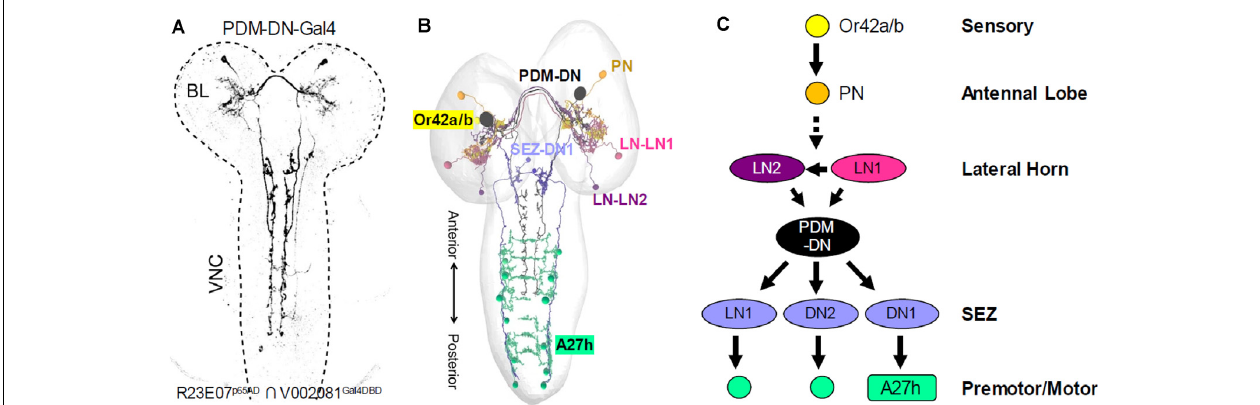
FIGURE 7 | Mapping larval sensorimotor circuits using Split Gal4 and connectomics. (A) The R23E07 p65AD ∩ V002081 Gal4DBD Split Gal4 driver was identified in a synaptic suppression screen to identify neurons involved in larval chemotaxis. This driver labels a single pair of descending neurons (PDM-DN). (B) Representation of the EM reconstructed neurons in the circuit for larval chemotaxis. Connectomics analysis revealed that the PDM-DN receives input from two lateral horn neurons, LH-LN1 and LH-LN1 (light and dark purple, respectively) and innervate three neurons in the SEZ, one of which is shown (SEZ-DN1, blue). The LH neurons are downstream of unpaired olfactory projection neurons (PN, orange) that receive input from Or42a and Or42b olfactory receptor neurons (yellow). The SEZ-DN1 neuron is the same SEZ neuron identified downstream of the larval “mooncrawler” neurons (i.e., Pair1) and connects to the posterior A27 h premotor neurons (teal). (C) Although certain details remain to be determined, such as the identity of the PNs that innervate the LH neurons and the functional interactions of the LH and PDM-DN neurons, the identified components of the larval chemotaxis circuit span the entire neuraxis from the sensory periphery to the final common pathway of the motor neurons [Adapted from Tastekin et al.